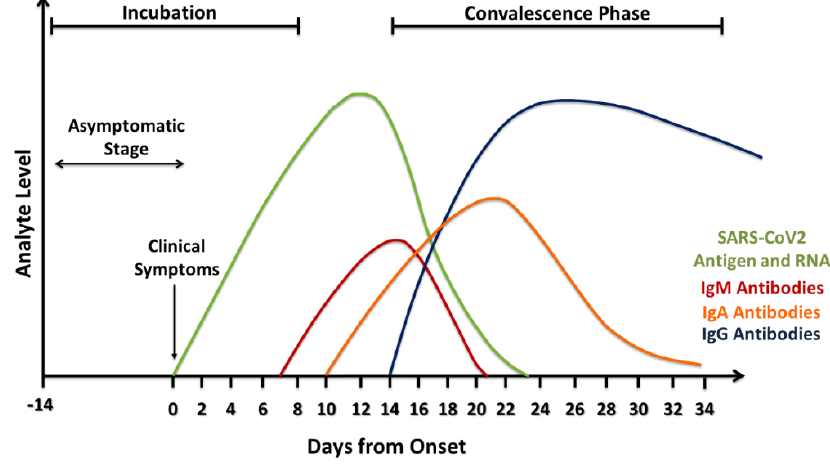
Figure 2. Estimation of biomarker levels during the COVID-19/SARS-CoV-2 infection.